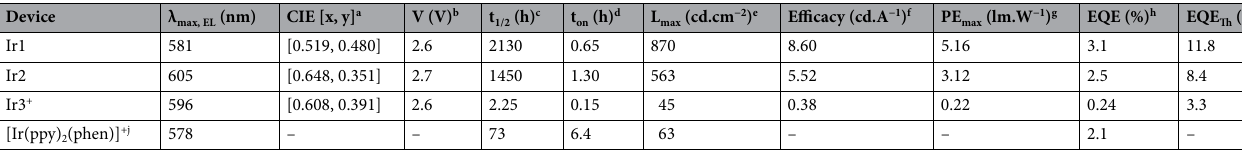
Table 3. Device Performance of the LEC: ITO/PEDOT:PSS/iTMC(Ir1, Ir2, Ir3 + ):[BMIM][PF 6 ]/Al. Operated under a pulsed current of 100 A·m −2 (1000 Hz, 50% duty cycle, block wave). a Commission Internationale de l’Eclairage color coordinates, 1931. b Driving voltage (after 15 h). c Lifetime: Time to reach one-half of the maximum luminance (Values obtained from extrapolation). d Turn-on time: time to reach maximum luminance. e Maximum luminance. f Maximum efficacy: ratio luminance/average current. g Maximum power efficiency. h Maximum external quantum efficiency of LEC devices. i Theoretical expected external quantum